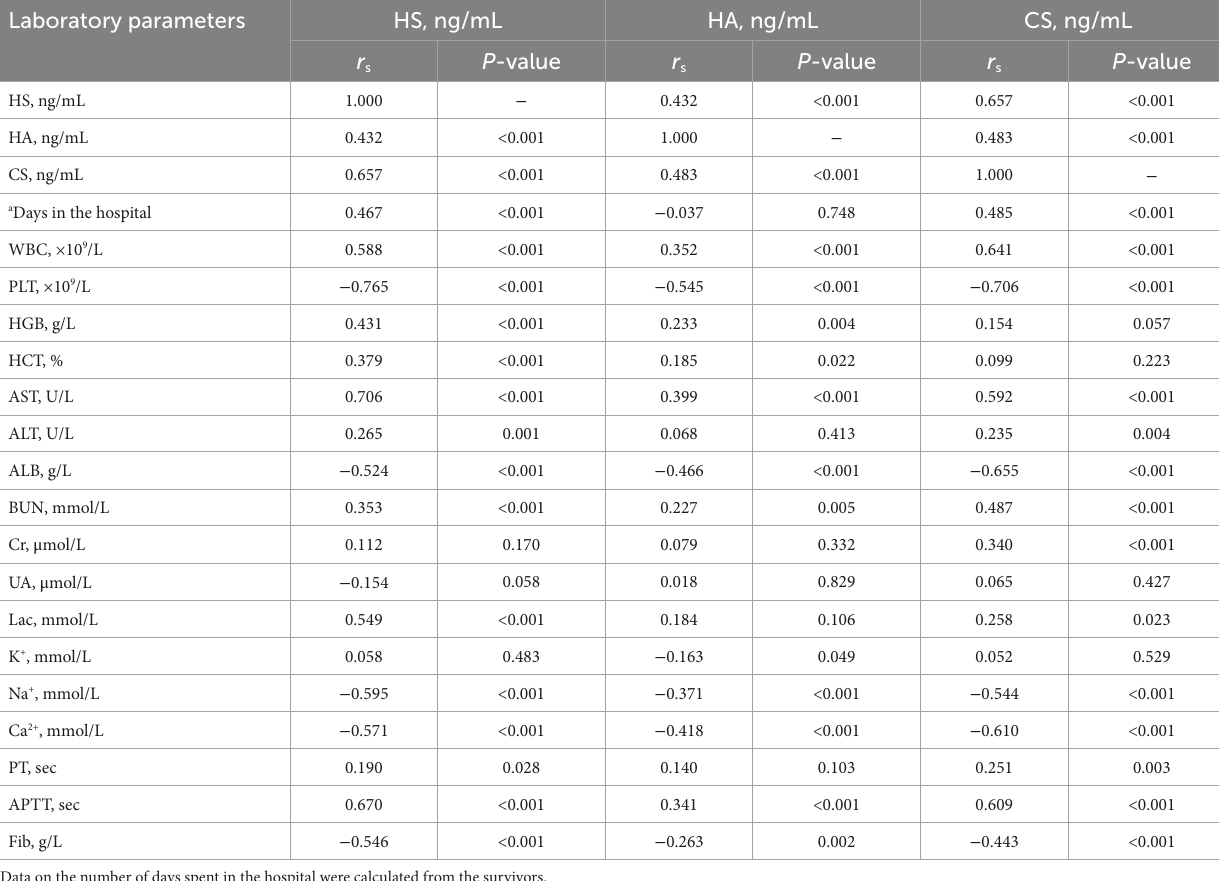
TABLE 2 Correlations between heparan sulfate (HS), hyaluronic acid (HA), and chondroitin sulfate (CS) and conventional laboratory parameters. Laboratory parameters